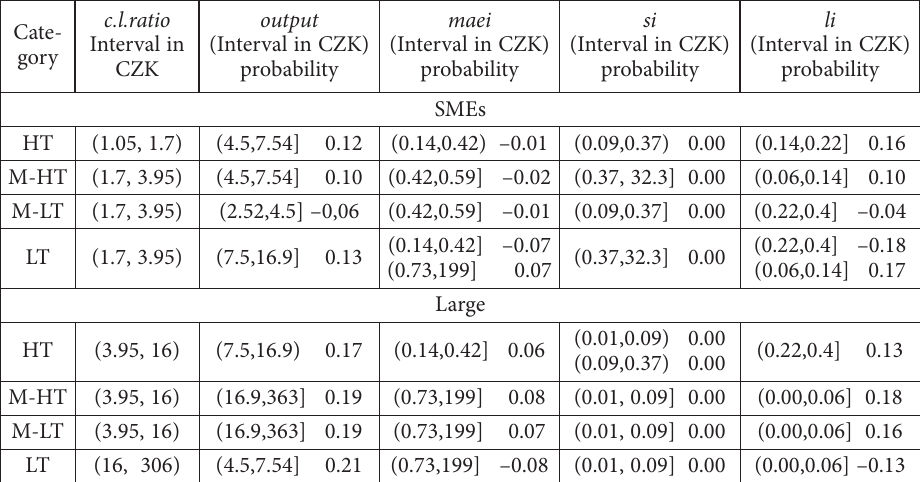
Table 4. Differences of probabilities after the c.l.ratio shift in selected indicators (source: authors’ calculation) c.l.ratio Cate- Interval gory